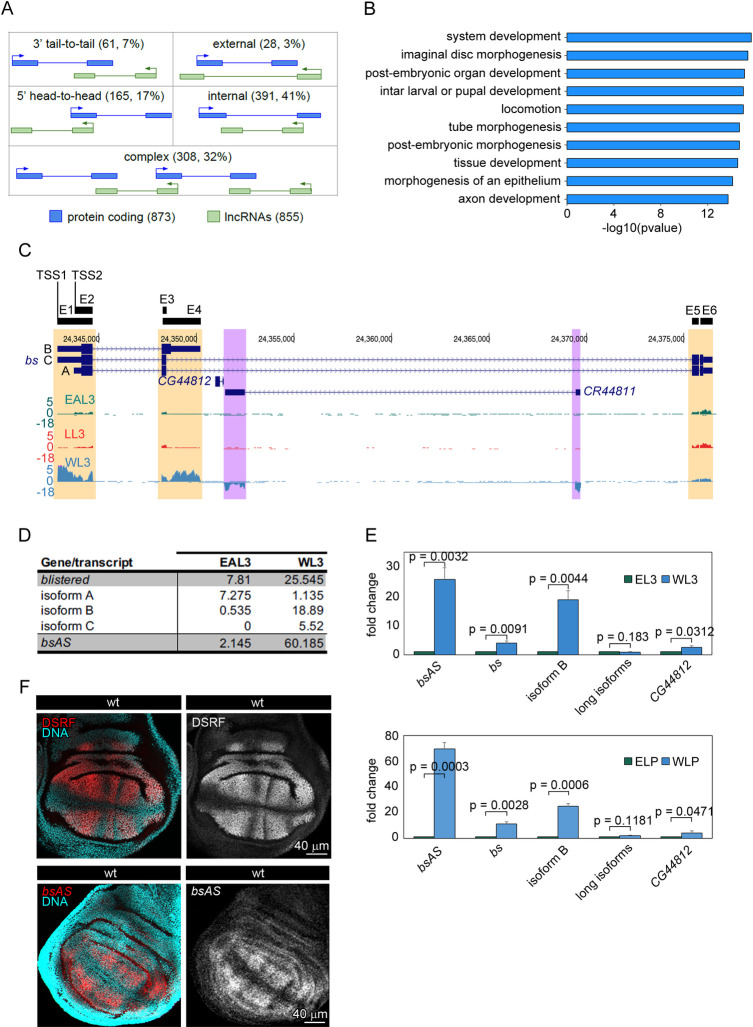
Natural antisense transcription in Drosophila melanogaster.(A) Configuration of sense/antisense (SA) pairs identified in D. melanogaster genome. We have identified 855 lncRNAs overlapping 873 coding genes in the fruit fly annotation. Around a 32% of the SA pairs present a complex configuration, meaning that one lncRNAs overlaps more than one coding gene or the other way around. (B) Gene Ontology Term Enrichment analysis of coding genes overlapping antisense transcripts. Sense genes are mainly related to development and morphogenesis categories. (C) Expression of the bs locus in the different tissues. Isoform B of bs is expressed mainly in wings, correlating with the highest expression of the antisense lncRNA CR44811. In the other tissues, the isoform A seems to be the predominant one. In the leg, also some expression of the lncRNA is observed. Regions showing differences in expression between tissues are highlighted (bs in orange and CR44811 in purple). (D) Expression of bs isoforms and bsAS in eye-antenna and wing imaginal discs at third instar larvae. The expression values, expressed in TPMs, represent the mean of two independent biological replicates. (E) Relative expression of bs and bsAS in wings and eyes at third instar larvae (L3 –upper panel–) and late pupa (LP –lower panel–) stages. bsAS and the short isoform B of the coding gene are much higher expressed in wings than in eyes, whereas there are not significant differences in the expression of the long isoforms. The protein coding gene CG44812, of unknown function, is almost not expressed in these tissues. Error bars depict Standard Error of the Mean (SEM) of at least three biological replicates. Statistical significance was computed by one-sample t-test. (F) Expression pattern of DSRF and bsAS in wt wing imaginal discs. Upper panels, immunostaining of DSRF (red and grey) in wt WL3. DSRF is expressed in the intervein region of the wing pouch. Lower panels, in situ hybridization of bsAS (red and grey) in WL3. The expression of bsAS mimics DSRF expression pattern in the intervein regions. Nuclei, stained with DAPI, are depicted in blue in all cases.